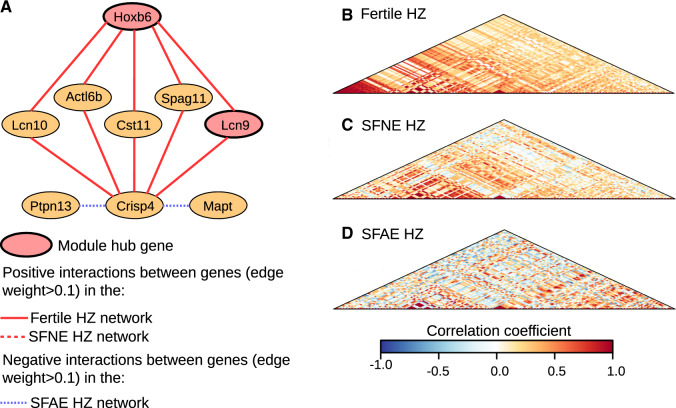
Disrupted interactions of Midnightblue module genes in subfertile HZ hybrids. (A) Interactions between Midnightblue module hub genes (red nodes) and genes with functions potentially related to sperm maturation (orange nodes) in HZ hybrids. Gene interactions with an edge-weight exceeding 0.1, as estimated using topological overlap matrices, are indicated using continuous, dashed, and fine-dashed lines for the fertile, SFNE, and SFAE hybrids, respectively. Positive interactions are shown in red and negative interactions are shown in blue. (B–D) Coexpression heatmaps showing pairwise correlations between expression values of Midnightblue module genes in fertile, SFNE, and SFAE HZ hybrids, respectively. Heatmaps reveal moderate weakening of gene interactions in the SFNE hybrids and weakening or reversal of interactions in the SFAE HZ hybrids, indicating more severe network disruption in the SFAE hybrid group.